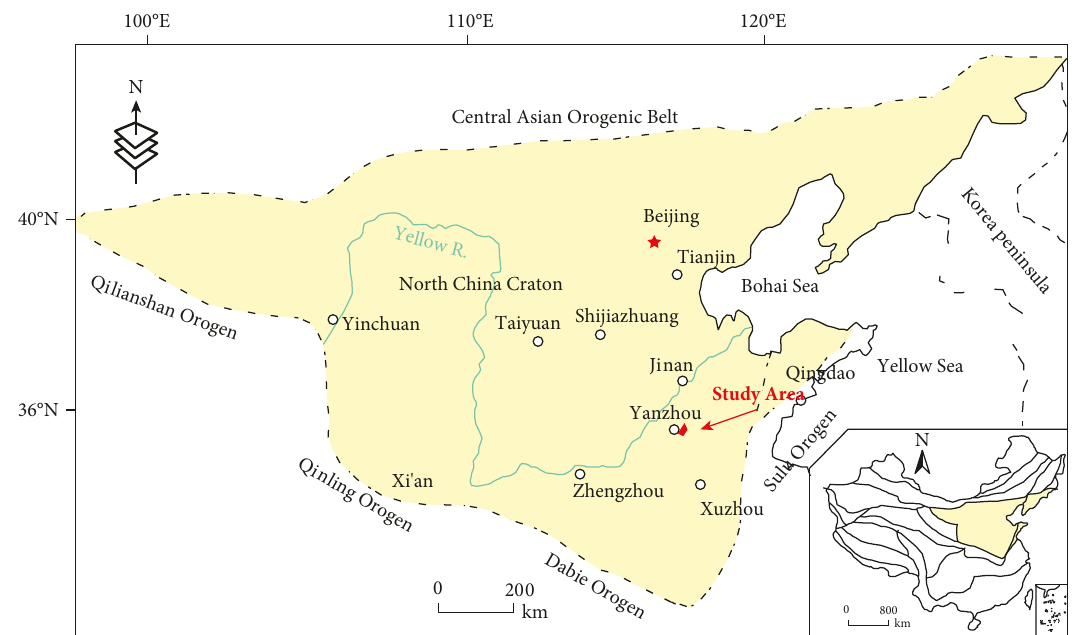
Figure 1: Location map of the study area (modi fi ed from